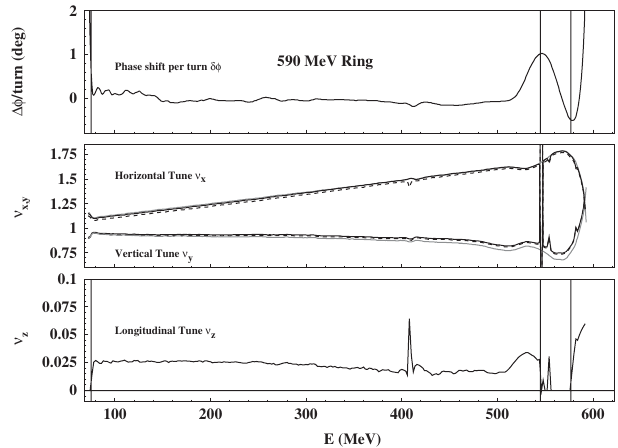
FIG. 2. Top: Phase shift per turn for the ring cyclotron com- puted from the measured magnetic field map. Middle: Horizontal and vertical betatron tunes of the ring cyclotron as computed by EO code (gray solid lines), the transfer matrix method over the EO (black solid lines), and with space charge (dashed lines). Bottom: Longitudinal betatron tune as induced by transverse- longitudinal coupling. The region with a negative slope of the phase shift is indicated by vertical lines. Without further field trimming, the longitudinal focusing is suppressed by the term (cid:1) h d" and the longitudinal beam size may increase. The calcu- dr lation has been performed for a beam current of 2.2 mA and ; " ; " Þ ¼ ð 1 : 5 ; 2 : 5 ; 0 : 5 Þ (cid:5) mm mrad . ð " x y z